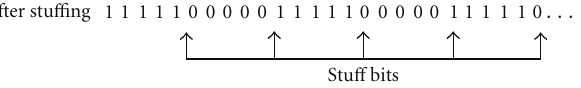
F 2: Worst-case bit